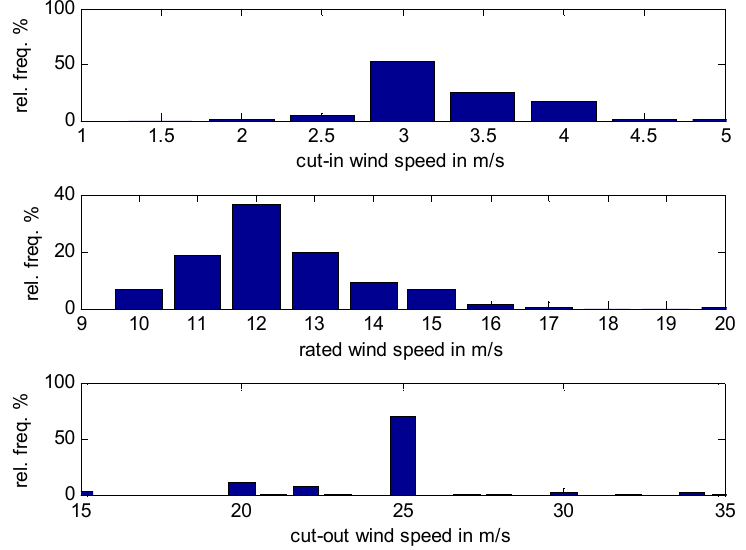
Figure 4. Distribution of the cut-in, rated and cut-out wind speeds for wind turbine generators